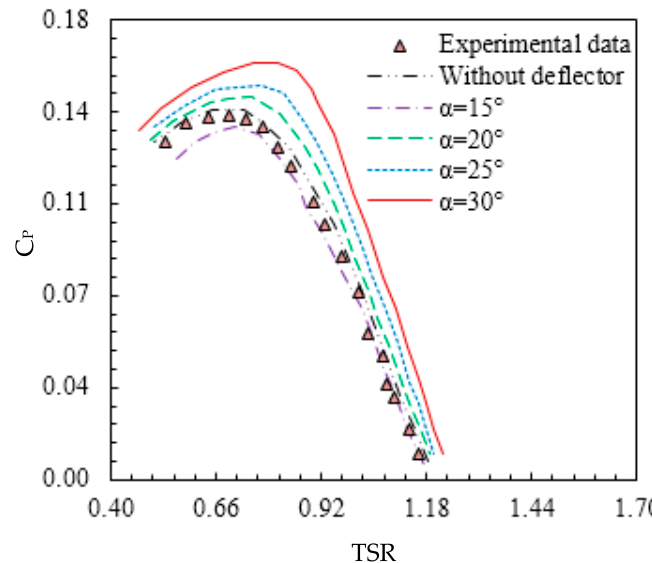
Figure 20. Power coefficient for different deflection angles.